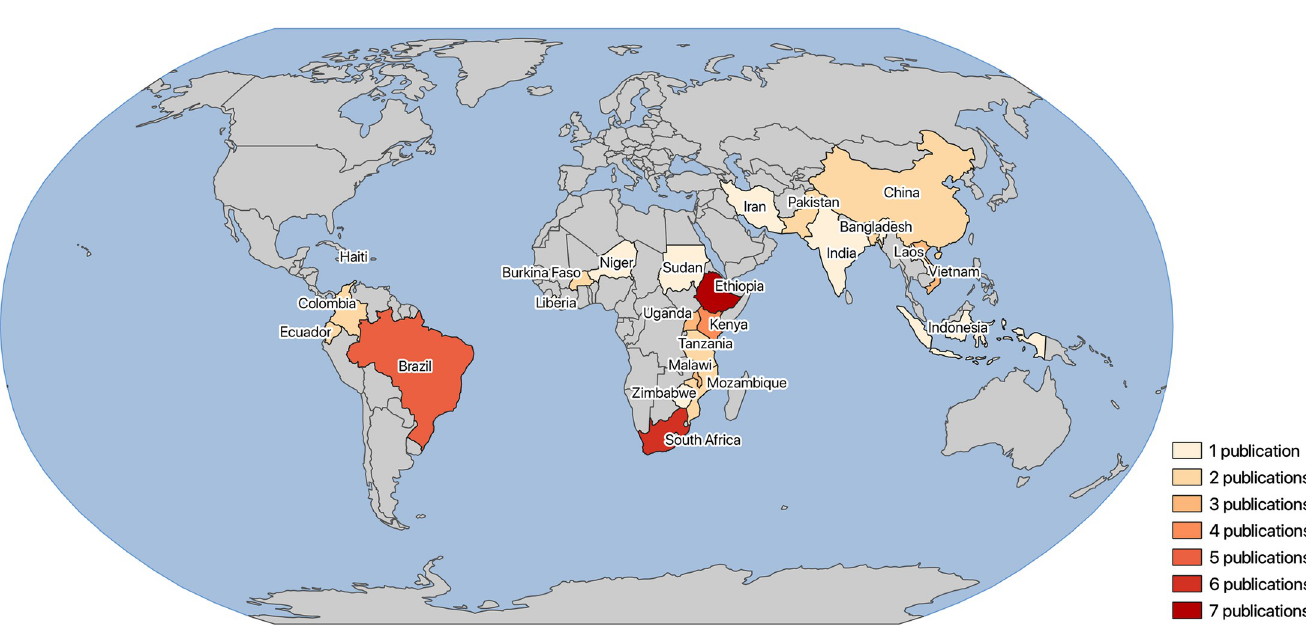
Fig 2. Countries where geographical accessibility studies were conducted in relation to infectious diseases. Colors indicate the number of publications per country. Map in Figure was created using shapefiles sourced from Natural Earth.